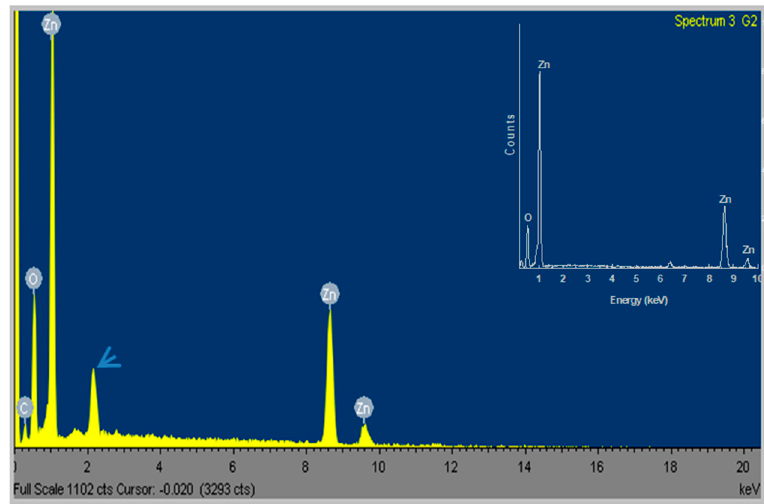
Figure 5. EDX spectrum of the plant-mediated G2 powder and the reference powder (inset); the arrow indicates Au originating from conductive material.